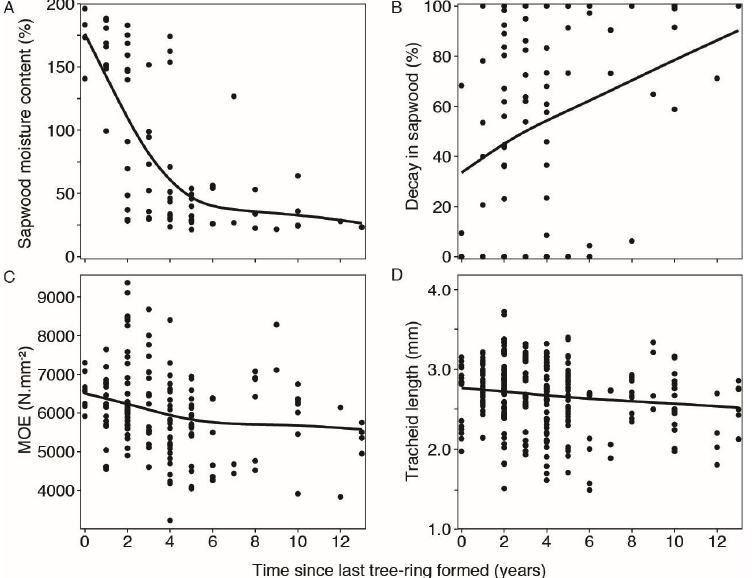
Figure 5. Generalized additive model (GAM) plots for sapwood moisture content ( A ), decay in sap- wood ( B ), MOE ( C ) and tracheid length ( D ) as a function of time since the last tree ring was formed by the tree. Trees that were still living and producing tree rings at the moment of sampling are included in the analysis at time = 0.